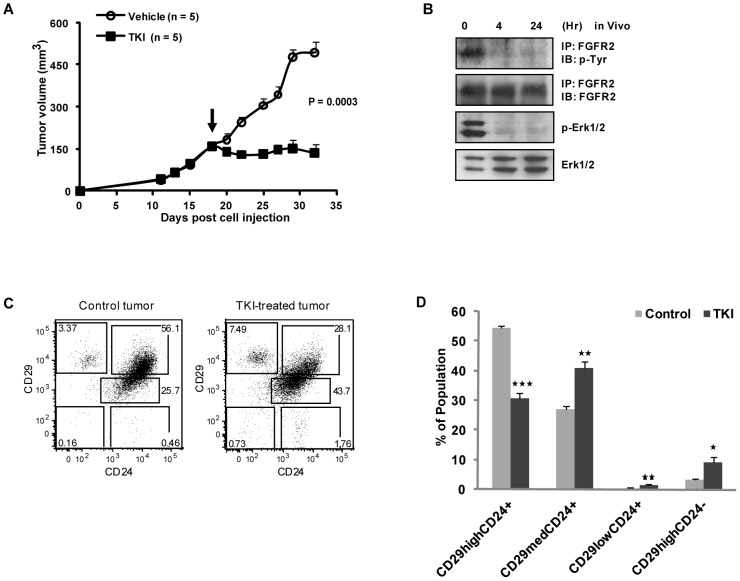
Antitumor Activity of FGFR Inhibitor as a Result of a Decrease in the Breast TIC Subpopulation In Vivo.(A) Antitumor activity of FGFR inhibitor, TKI258. Daily oral administration of TKI258 at 50 mg/kg was initiated in tumor-bearing NOD/SCID mice (n = 5 per group) when the MMTV-PyMT breast tumors reached ∼150 mm3 in volume. P value at day 32 is indicated. (B) Reduced phosphorylation of FGFR2 and Erk1/2 upon treatment of breast tumors with TKI258. Breast tumors were collected at predose, 4 and 24 hours after administration of a single oral dose of TKI258. Tumors were homogenized, immunoprecipitated for FGFR2 and immunoblotted with anti-phosphotyrosine to evaluate phosphorylation of FGFR2. The membranes were reprobed to evaluate total level of FGFR2 protein. (C) Flow cytometry analysis of CD24 and CD29 expression for TIC and non-TIC subpopulation frequencies in TKI258- or control-treated breast tumors. (D) Quantification of TIC and non-TIC subpopulations in TKI258- or control-treated breast tumors determined by flow cytometry analysis (C). Data (n = 3) represent mean ± SEM. Statistical comparison with control treatment (*P<0.04; **P<0.02; ***P<0.002).